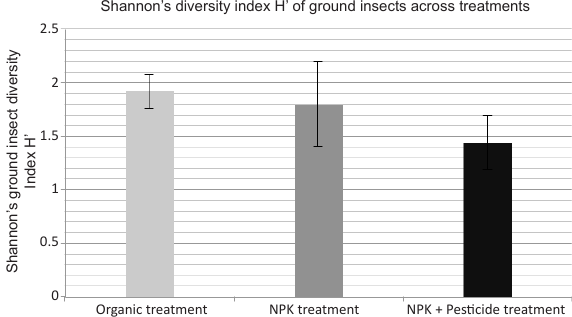
Figure 2. Bar plot for ground insects shows the mean Shannon’s diversity index H’ for all treatments with their 95% confidence intervals (CI). Note the 95% CI for treatments organic (G) and NPK + pesticide (P) do not overlap.